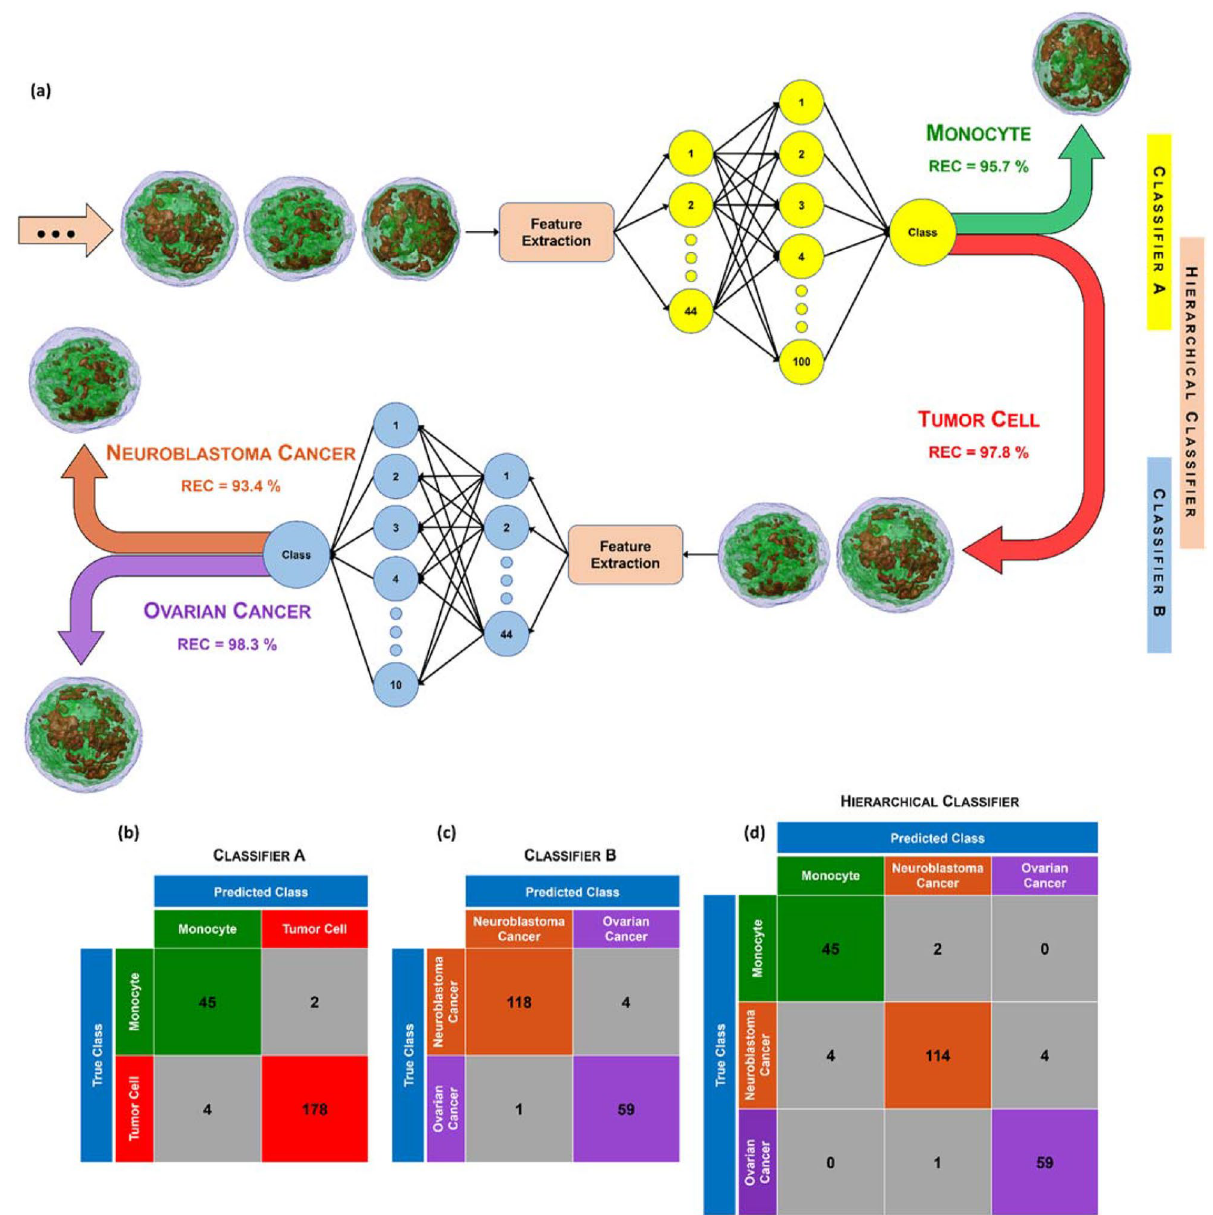
Figure 4. ML classification of 3D RI tomograms. ( a ) Conceptual scheme of the hierarchical model made of two successive shallow neural networks (classifier A and classifier B ), with highlighted its recall values. The classifier A detects MCs vs. tumor cells. The classifier B recognizes NB cells vs. OC cells. The hierarchical classifier identifies MC cells versus NB cells versus OC cells. Cells are visualized through a 3-isolevels representation (the RI thresholds are set as the maximum RI value multiplied by 0.6 and 0.75). ( b – d ) Confusion matrices of the classifier A , classifier B , and hierarchical classifier,